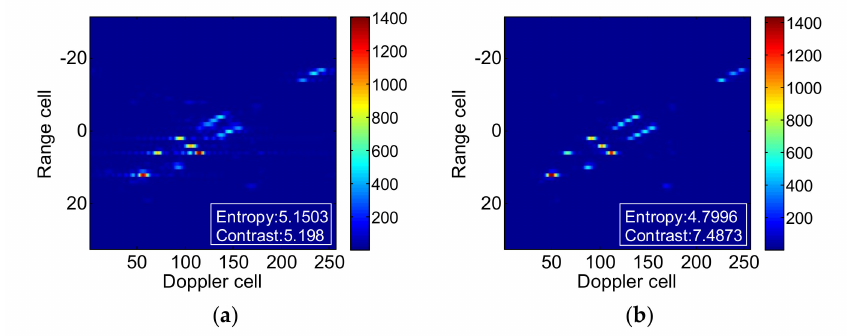
Figure 15. RID image based on smoothed pseudo Wigner-Ville distribution. ( a ) At time instant 0.0005 s; ( b ) at time instant 0.0015